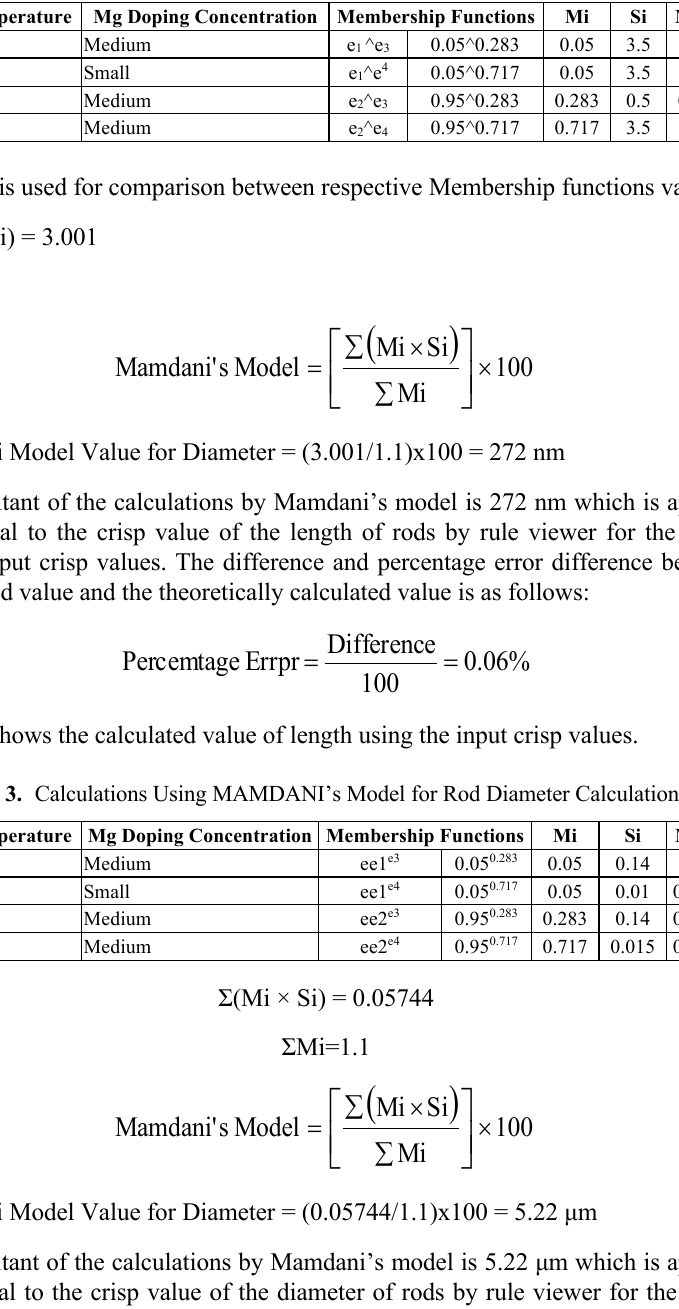
Table 2. Calculations Using MAMDANI’s Model for Rod Diameter Calculation